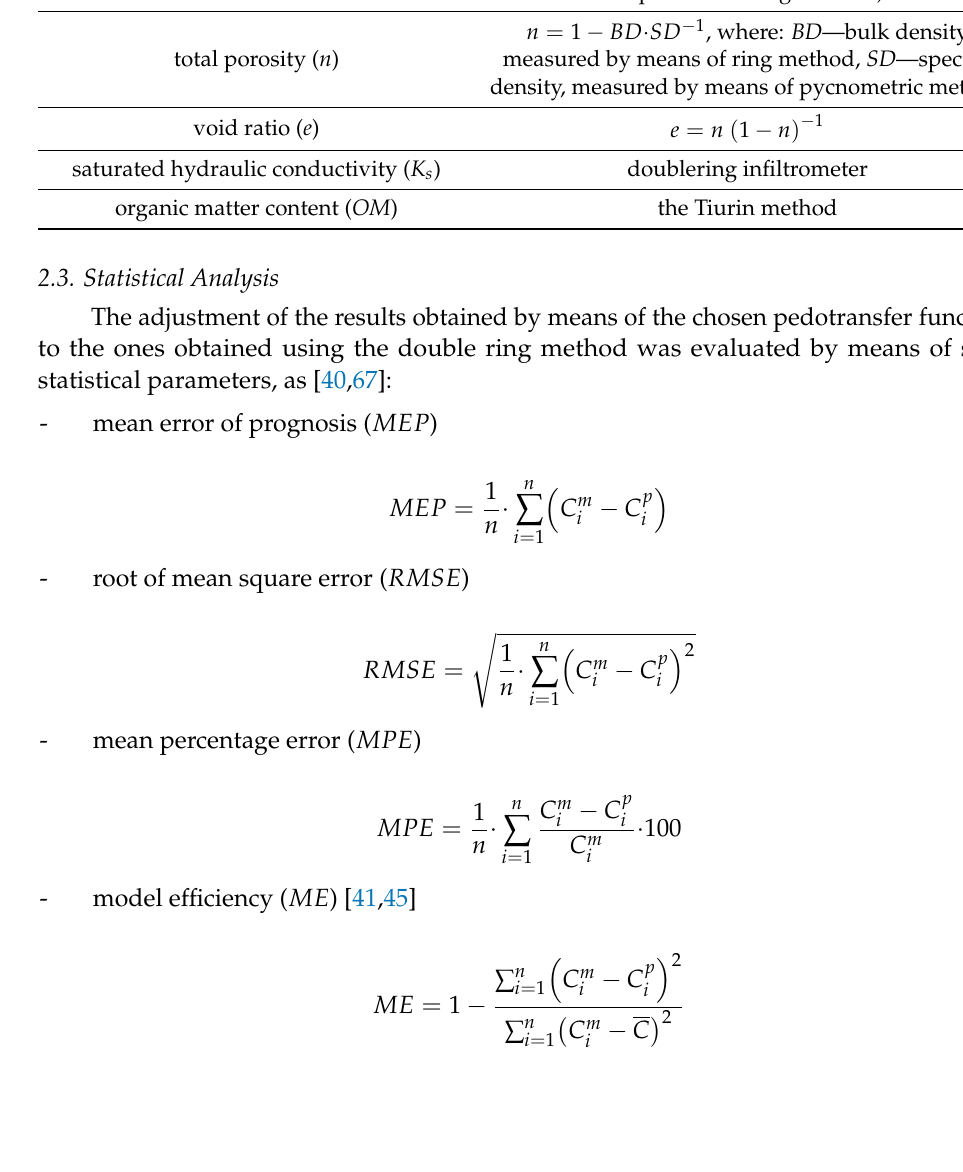
Table 1. Methods for determination of soil properties. Soil Property Methods the Casagrandesedimentation and sieve methods; classification of fractions and granular groups was texture carried out according to USDA (United